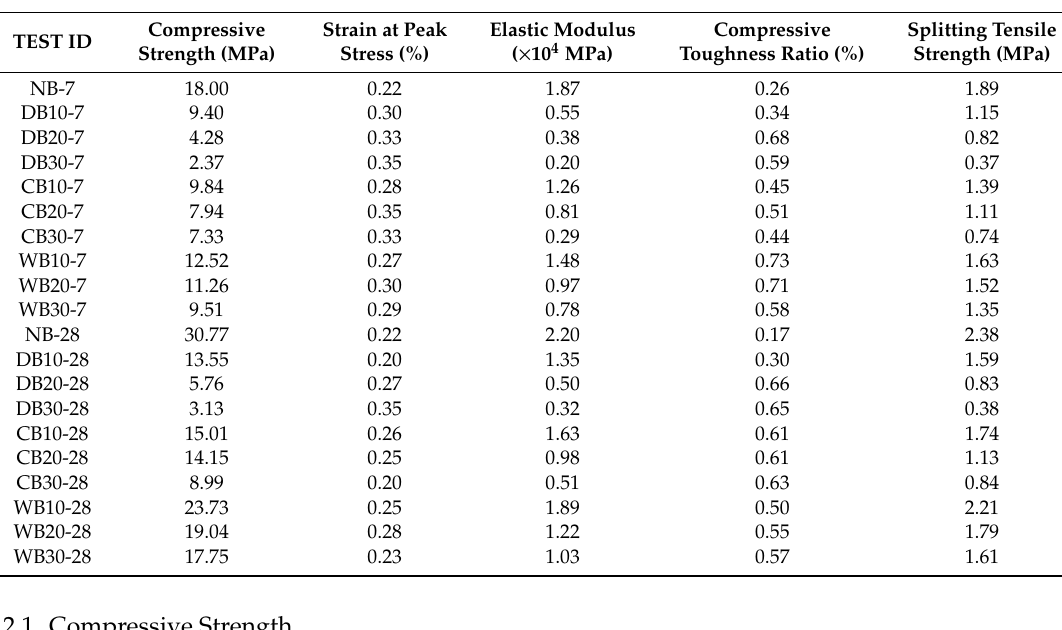
Table 4. Experimental results.